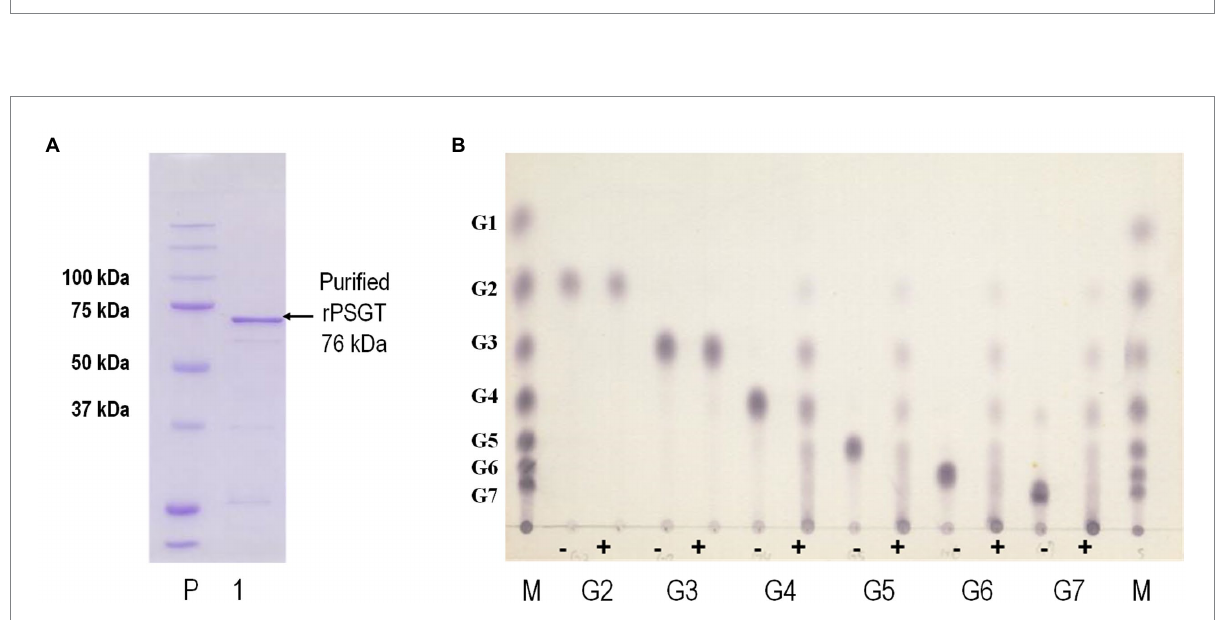
FIGURE 2 Biochemical characterization of recombinant PSGT (rPSGT). (A) SDS-PAGE of purified rPSGT; Lane P, protein ladder; Lane 1, purified band of rPSGT. (B) Substrate specificity of rPSGT toward various maltooligosaccharides from maltose to maltoheptaose. Each substrate (10 mM) was reacted with rPSGT at 80 ° C for 12 h. ( − ) and (+) indicate presence and absence of enzyme,